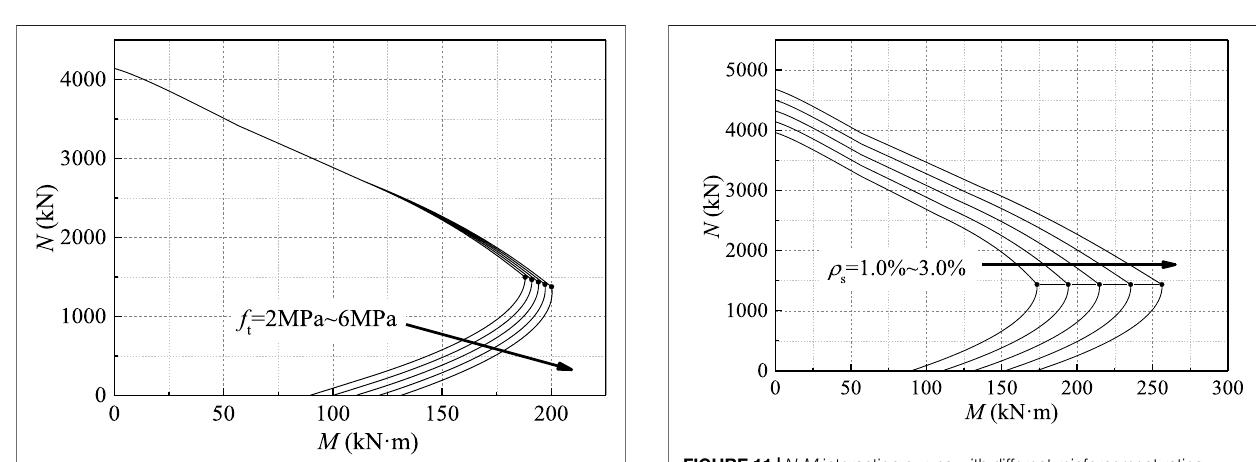
FIGURE 11 | N-M interaction curves with different reinforcement